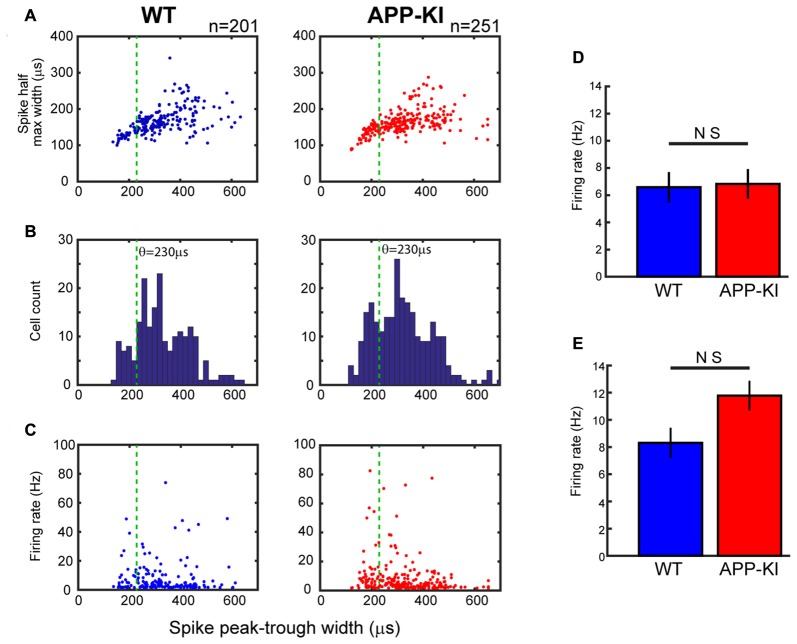
Neurons in APP-KI mice showed normal spike waveform and firing rate. (A) Plot of individual neurons for spike half-maximum width as a function of spike peak-trough width in WT mice (left) and APP-KI mice (right; n = 201 and 251 neurons, respectively). Green lines indicate 230 μs threshold used for separating interneurons and pyramidal neurons (see text). (B) Distributions of spike peak-trough width from WT mice (left) and APP-KI mice (right). Note that both distributions have a gap at 210–250 μs, which presumably represents the gap of different spike width between interneurons and pyramidal neurons. (C) Plot of individual neurons for mean firing rate during theta periods as a function of spike peak-trough width in WT mice (left) and APP-KI mice (right). (D,E) Mean firing rate for putative pyramidal neurons (D, n = 171 and 191 for WT and APP-KI) and interneurons (E, n = 30 and 60 for WT and APP-KI). No difference in firing rate was observed (Mann-Whitney U test).